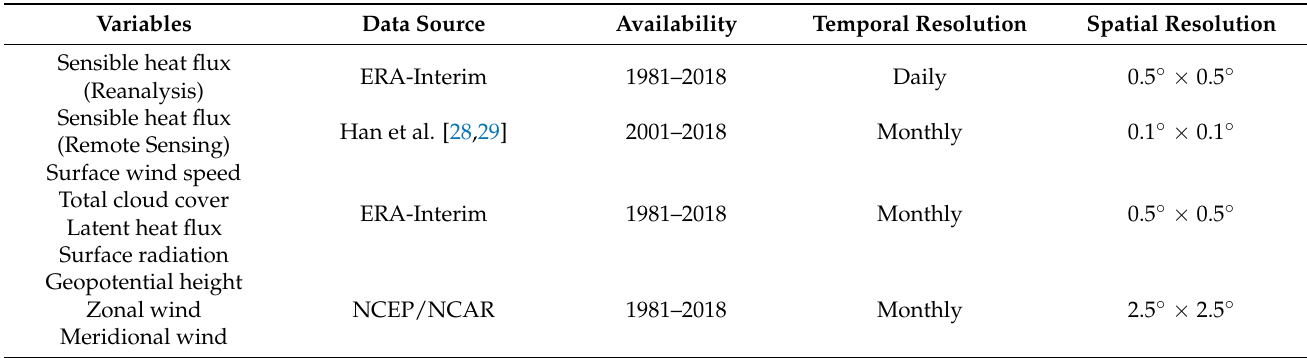
Table 1. Summary of the datasets used in the